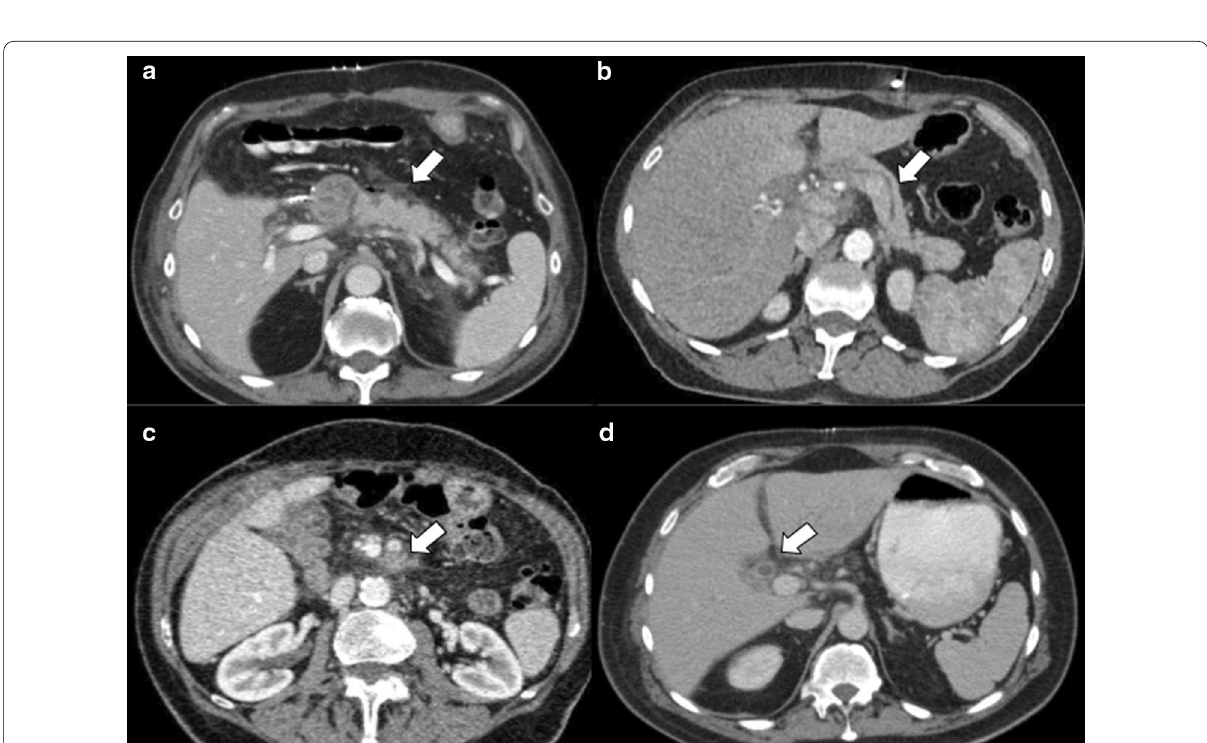
Fig. 7 Normal postoperative findings: ( a ) Peripancreatic fat stranding; ( b ) Mild pancreatic duct dilatation; ( c ) Perivascular cuffing; ( d ) Intrahepatic biliary duct enhancement and